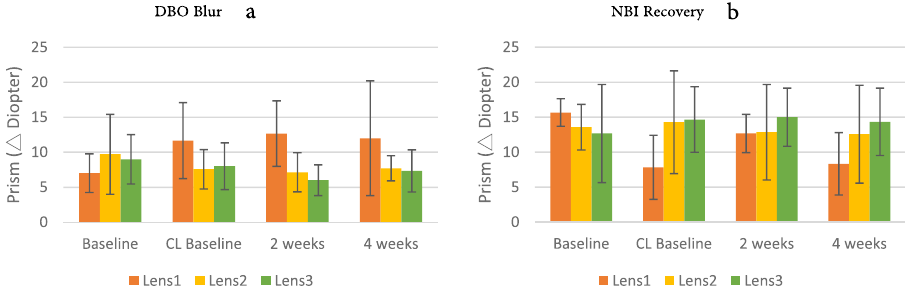
Figure 2. ( a ) DBO (Distance Base Out) blur; ( b ) NBI (Near Base in) recovery performance on Groups × Measurements; error bars represent the standard deviation.